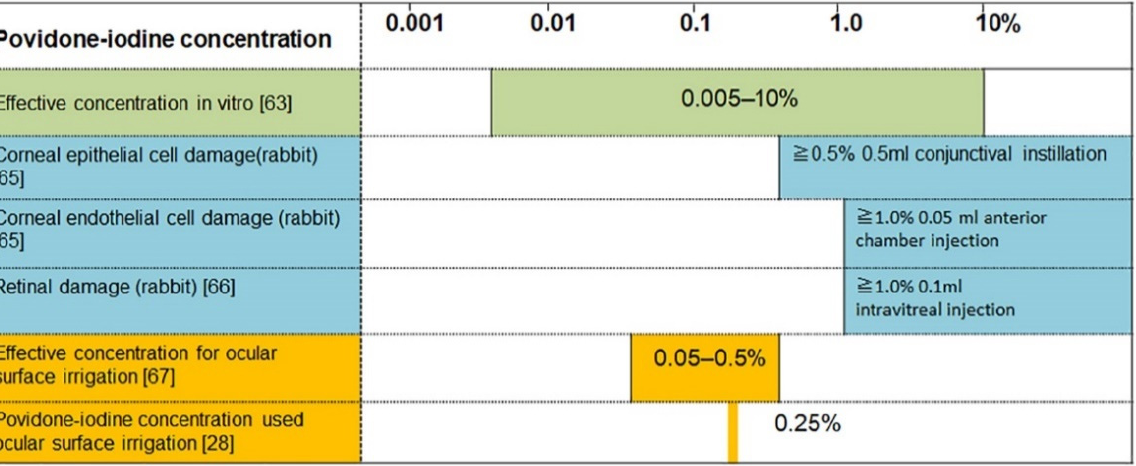
Figure 7. Concentrations of povidone-iodine used for ocular surface irrigation. The concentrations that cause damage to corneal endothelial cells, corneal epithelial cells and retina are shown; 0.025% povidone-iodine is the median for the concentration range of 0.05–0.5% that is suitable for ocular surface irrigation. (Modified from [28]).